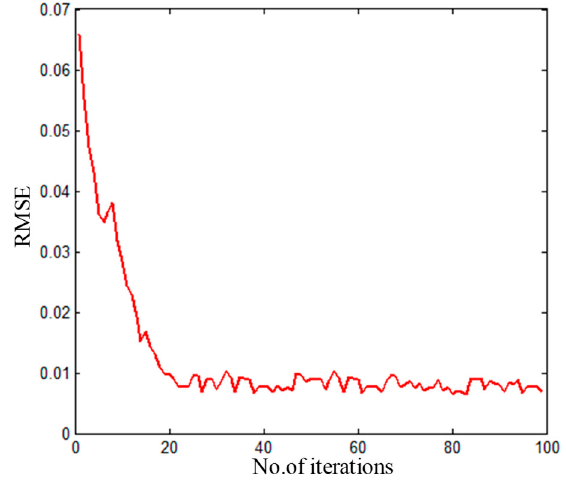
Figure 7. The RMSE of the K-SVD algorithm for different numbers of iterations.